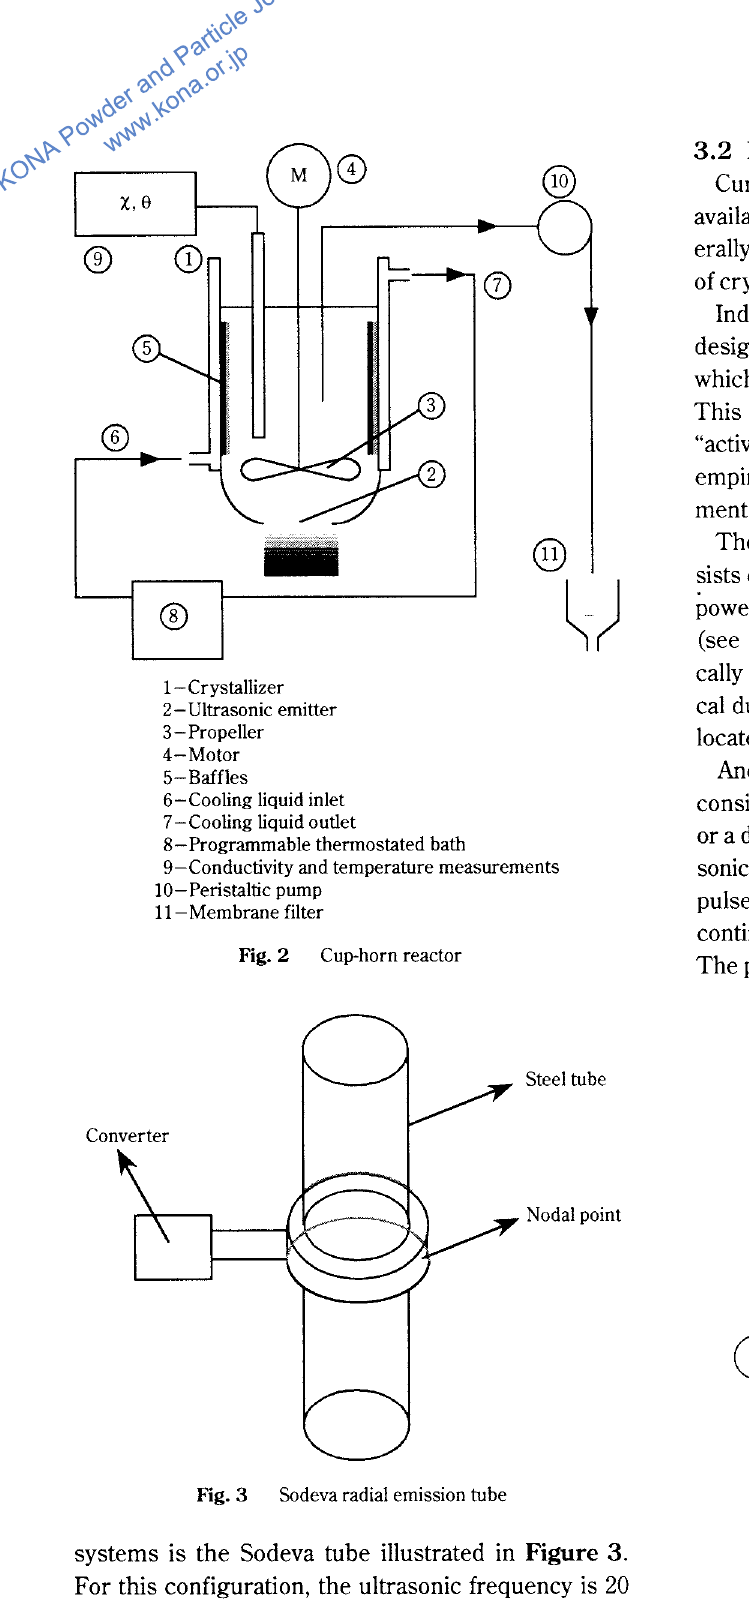
Fig. 3 Sodeva radial emission tube